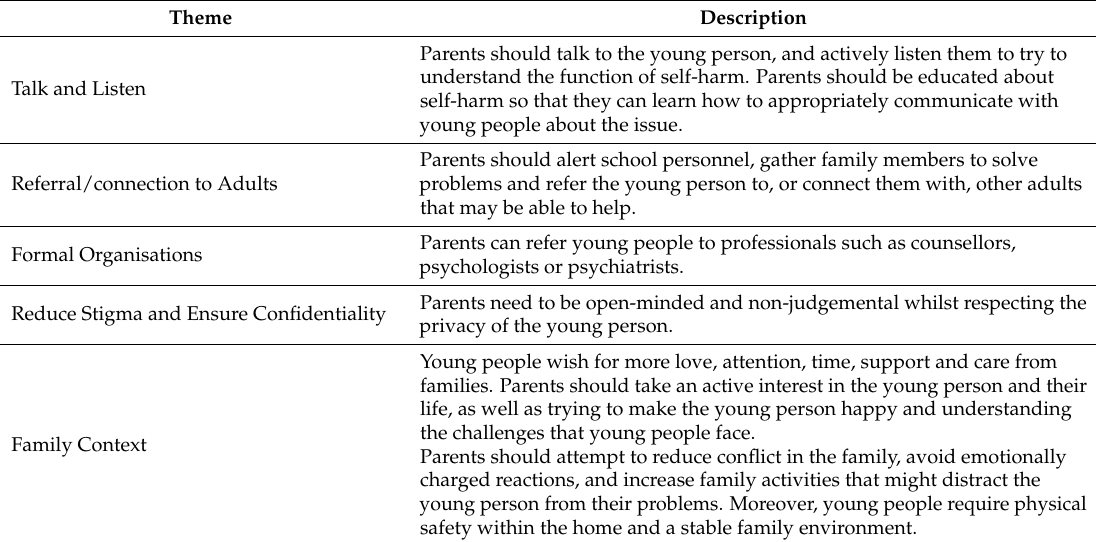
Table 3. What young people believe parents can do to help young people whom have engaged in